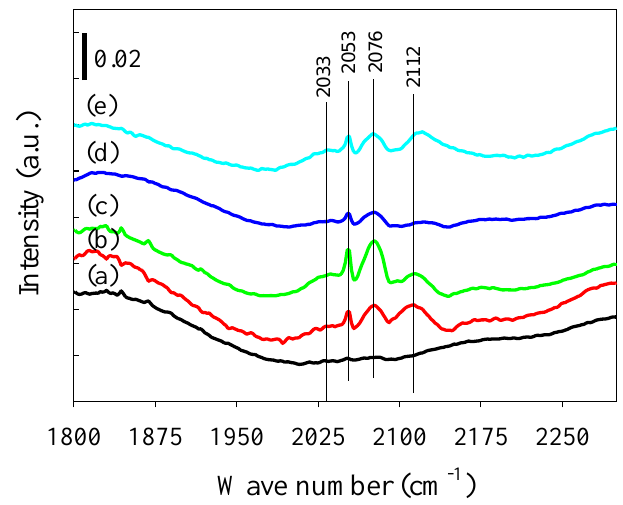
Figure 8. In situ DRIFT spectra of Au/La 2 O 3 /Al 2 O 3 catalysts after methanol adsorption at 160 ◦ C and subsequent He purge for 5 min: ( a ) La 2 O 3 /Al 2 O 3 ; ( b ) Au/La 2 O 3 /Al 2 O 3 (H); ( c ) Au/La 2 O 3 /Al 2 O 3 (S35); ( d ) Au/La 2 O 3 /Al 2 O 3 (S115); ( e ) Au/La 2 O 3 /Al 2 O 3